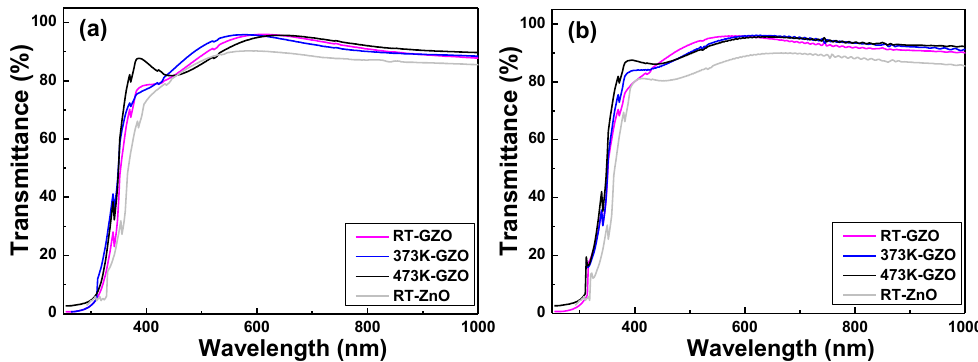
Figure 4. Transmittance spectra of the undoped ZnO thin films and GZO thin films deposited as a function of deposition temperature and different substrates: ( a ) glass and ( b ) PI.